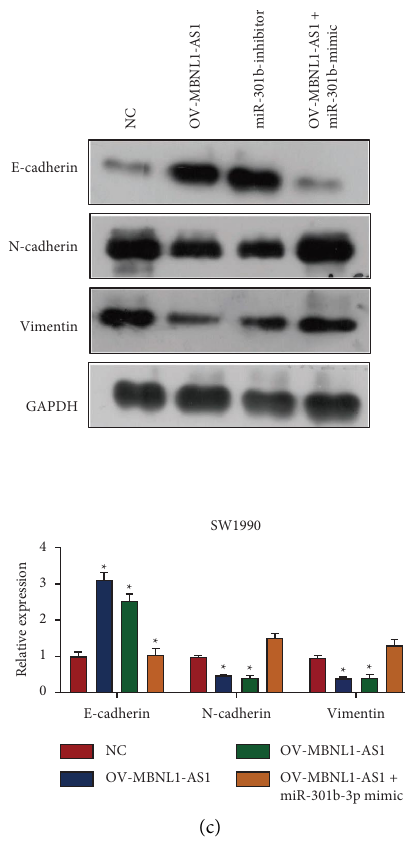
Figure 5: MBNL1-AS1 suppressed cell metastasis in PAAD by targeting miR-301b-3p. (a) Cell migration ability of PANC-1 and SW1990 with diferent intervention. Scale bar � 200 μ m. (b and c), Te EMT markers (E-cadherin, N-cadherin and vimentin) in PANC-1 and SW1990 with diferent intervention. OV means overexpression. Compared to the NC group, ∗ P < 0 . 05. Compared to the OV-MBNL1-AS1 group, # P < 0 .